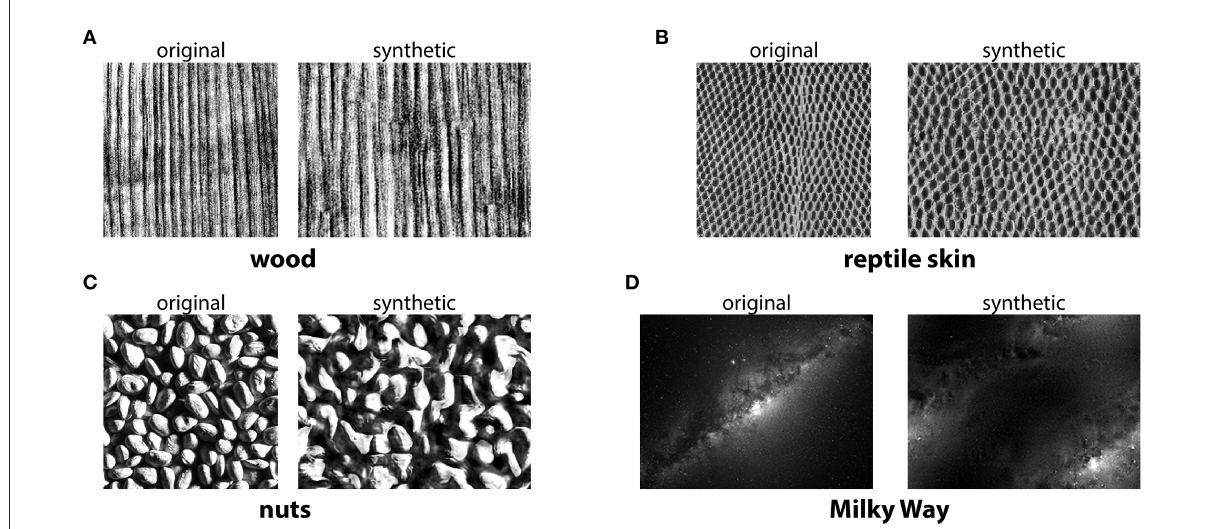
FIGURE3 Photorealistic textures from the Portilla-Simoncelli texture model. The synthetic images were generated using the Matlab code from https:// github.com/LabForComputationalVision/textureSynth. (A–D) The original samples were taken either from the same repository (for “reptile skin” and “nuts”), or from other freely available images on the internet (for “wood” and “Milky